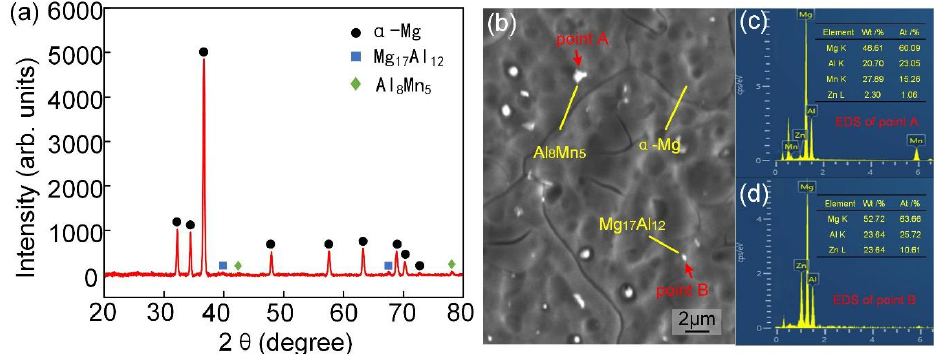
Figure 8. Chemical composition of thin-walled components. ( a ) XRD phase spectral lines; ( b ) Test point location for EDS; ( c ) Composition spectral line at point A; ( d ) Composition spectral line at point B.